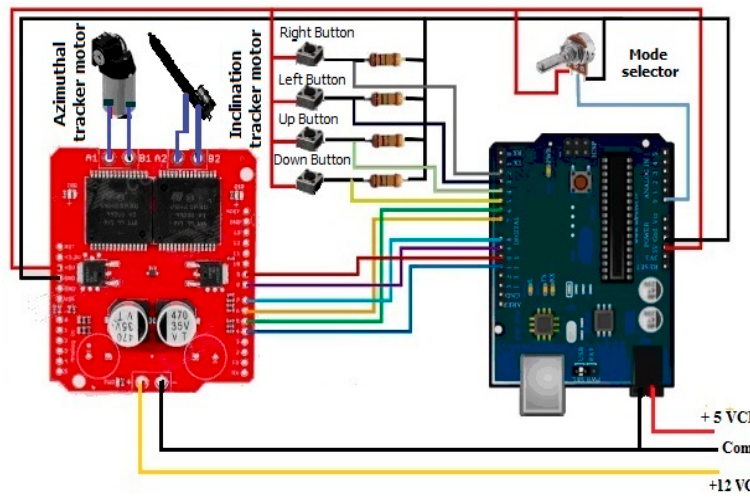
Figure 8. Controller connection schematic diagram.